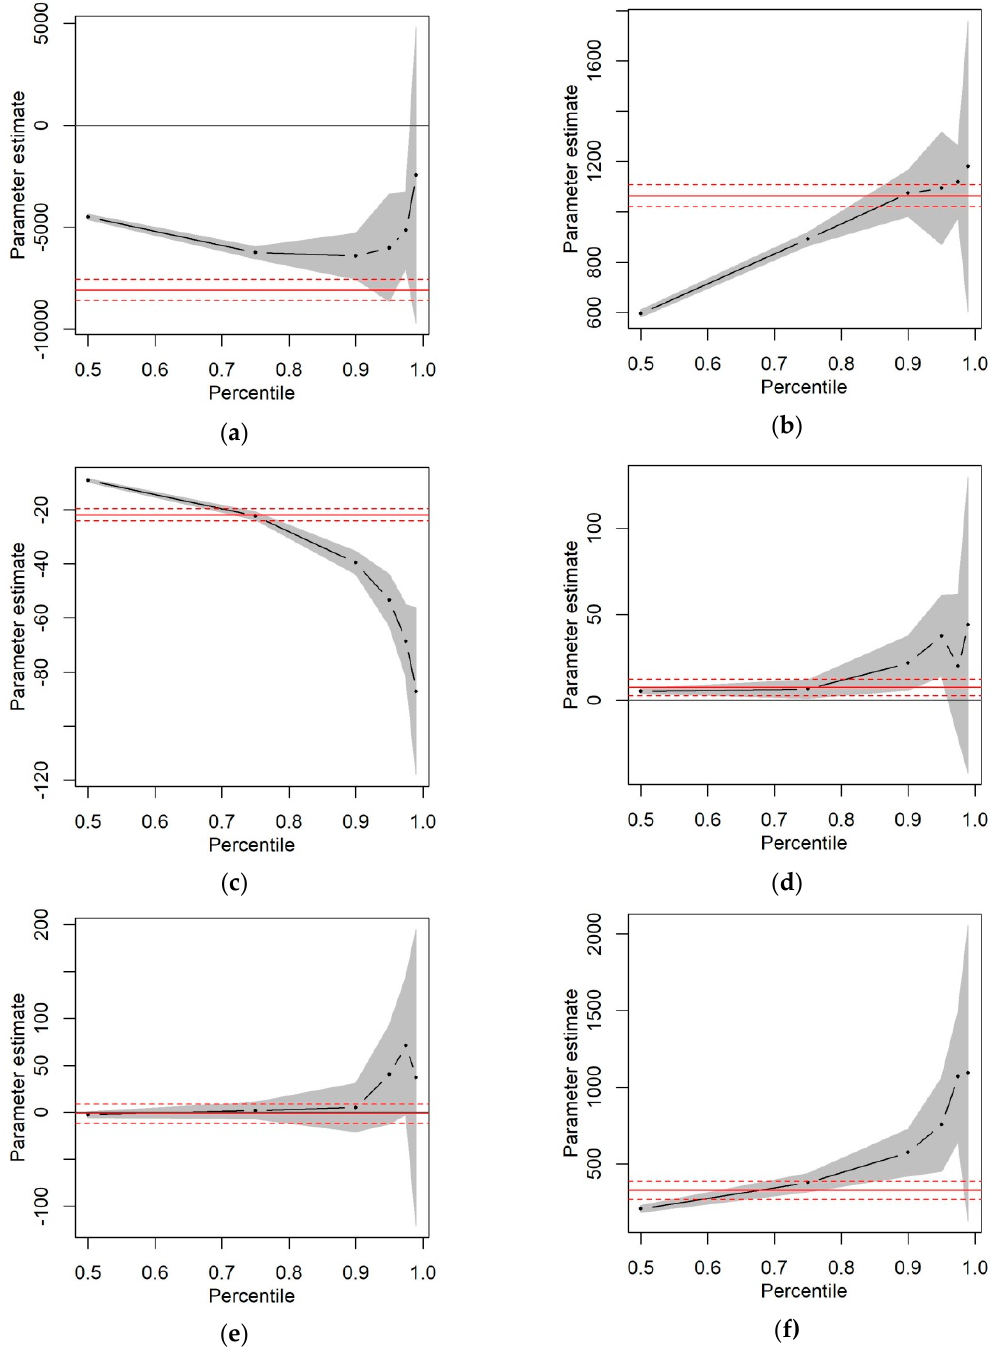
Figure 2. Parameter estimates at different levels of the quantile. Confidence intervals at a 5% level of significance. The horizontal red line represents the corresponding parameter estimate in a classical linear regression model. ( a ) Intercept; ( b ) lnkm; ( c ) pkdr_vurba; ( d ) pkdr_nocturn; ( e ) age; and ( f ) gender.